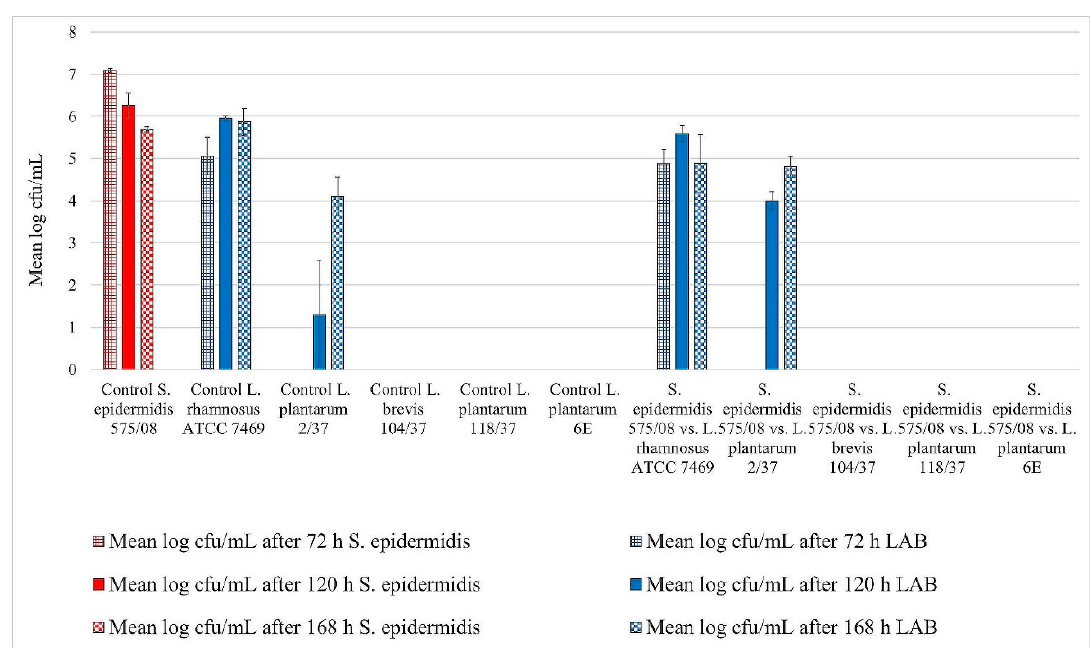
Figure 2. Biofilm challenge: S. xylosus (35/07) vs. LAB. Cfu/mL values are shown transformed by log (± standard error of the mean). Foods 2019 , 8 FOR PEER REVIEW